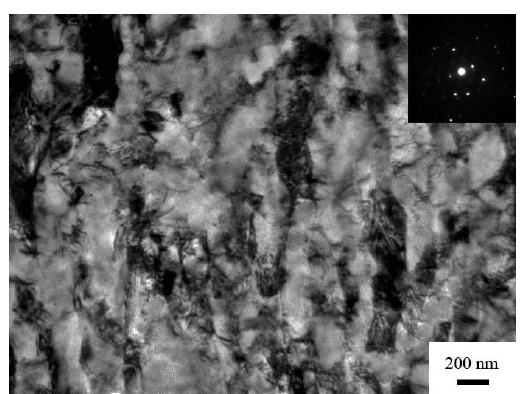
Figure 4: Structure (TEM) of the Cu-0.55Cr-0.2Cd-0.02Zr alloy after eight ECAP cycles.